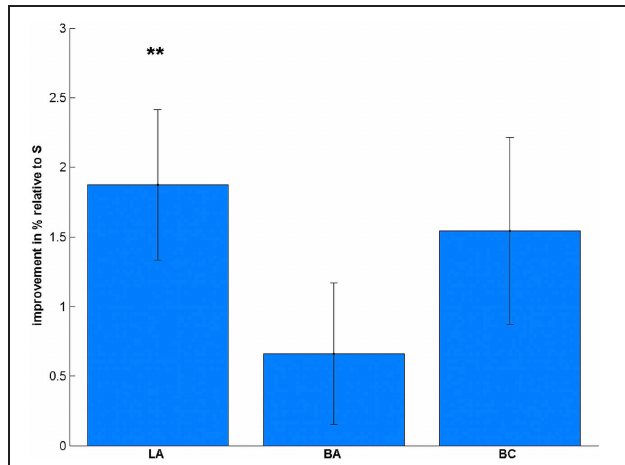
FIGURE 3 | Stimulation-induced accuracy changes in the number comparison task. Subjects significantly improved their accuracy after LA stimulation, but not after BA or BC compared to S. ∗∗ p < 0 . 01, multiple comparison corrected.